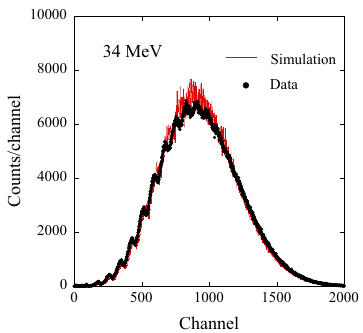
Figure 4. (Color online) Experimental multi-photon spectrum at 34 MeV in comparison with the best-fit Poisson